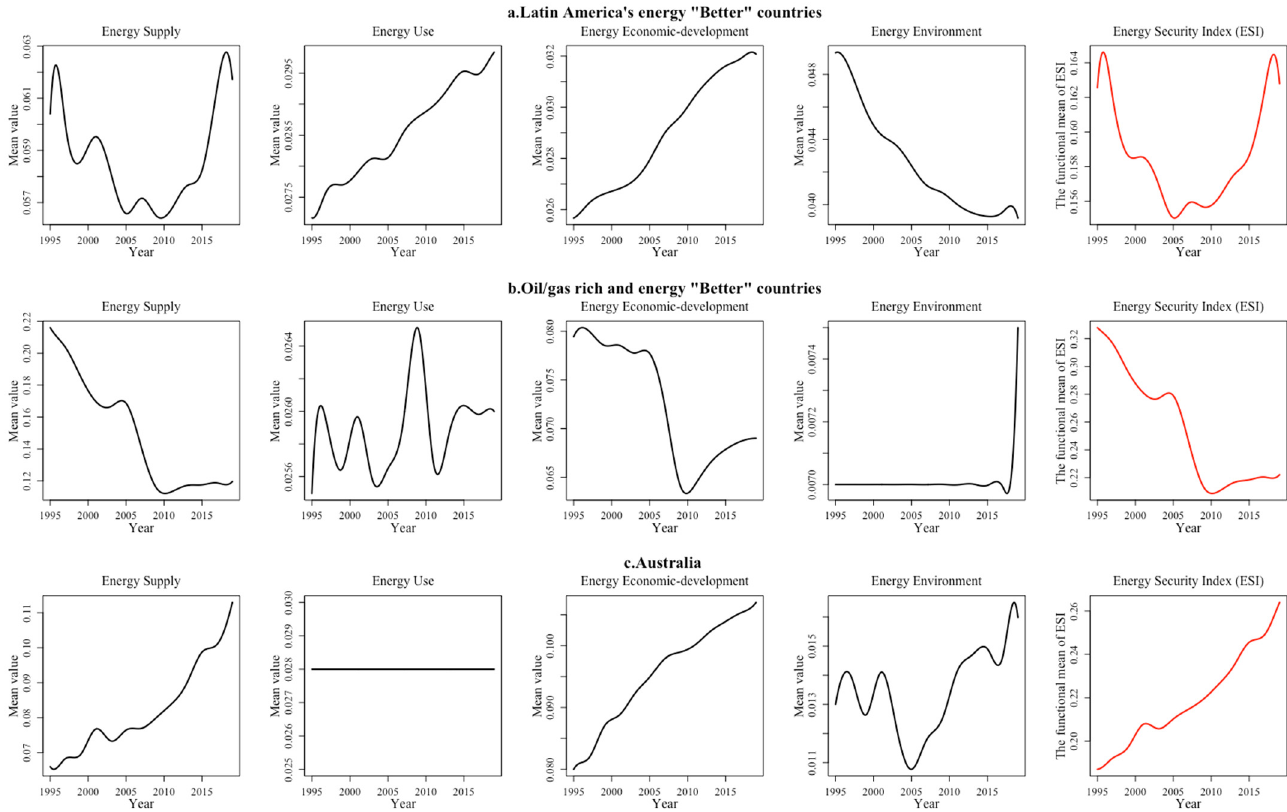
Figure 10. “Better” regional energy security system performance in four dimensions (part 2). (3) The countries with “Good” energy security are mainly located in the Middle East, Southeast Europe and East Asia. Restricted by the political environment, economic level and modernization process, the security of regional energy system in these countries is facing challenges or undergoing rapid transformation. The Middle East, for example, has rich hydrocarbon resources, high levels of energy supply and advanced economic technology, but their economy is largely driven by the petrochemical industry, resulting in low industrial energy efficiency and high greenhouse gas emissions. Meanwhile, coupled with the continuous political conflicts and economic turmoil, their energy security use index, environmental index and economic development index all lag behind the supply index and the overall energy security index shows a downward trend (Figure 11a). After the dramatic changes in Eastern Europe, Ukraine, Albania, Turkey and Russia joined the Black Sea Economic Cooperation (BSE), to some extent, stabilizing energy markets, diversifying energy structure and stabilizing domestic energy prices. Generally speaking, the energy security index fluctuates in some years, whereas the energy security index in all dimensions and the overall energy security indexes shows an increasing